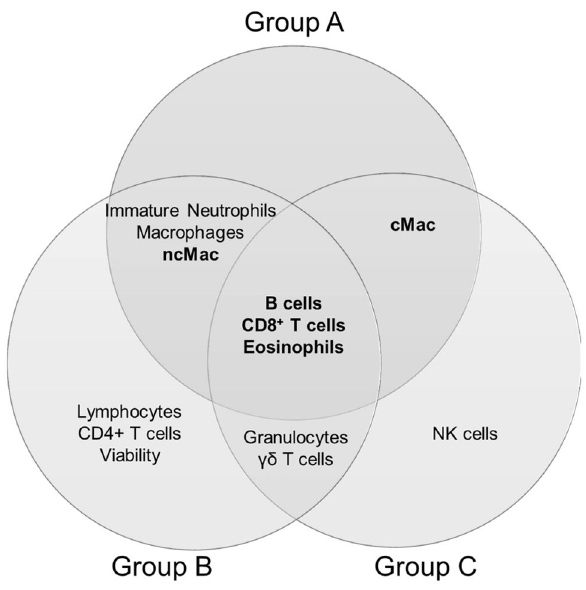
Figure 7. Overview of the most discriminating subpopulations or features of sPLS-DA based on only milk parameter, to separate the treatment